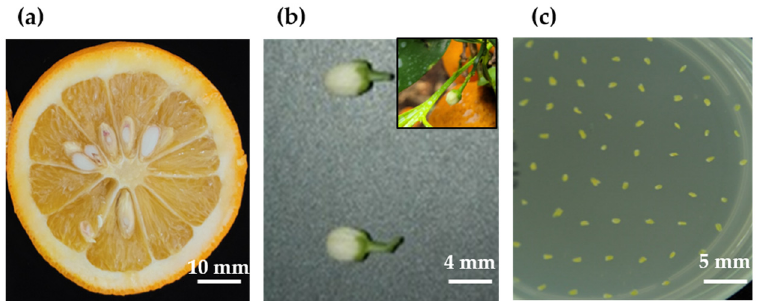
Figure 9. Citrus aurantium L. (sour orange) anther culture. ( a ) Transverse plane of a sour orange fruit; ( b ) sour orange flower bud; ( c ) anther culture in a Petri dish.